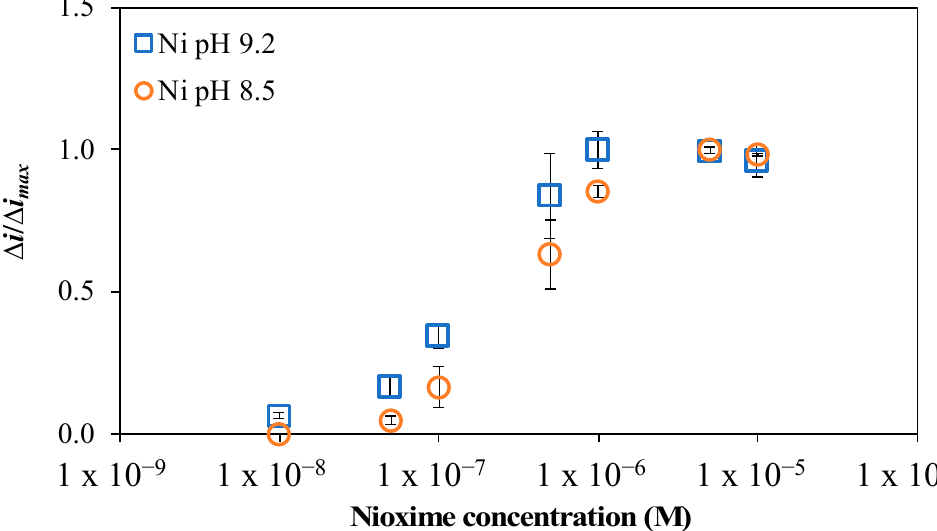
Figure 1. Effect of nioxime concentration on the peak current intensity of 12 nM Ni(II) in a synthetic solution (0.02 M NaNO 3 and 0.04 M borate) at pH 8.5 (orange open circle) and 9.2 (blue open square).